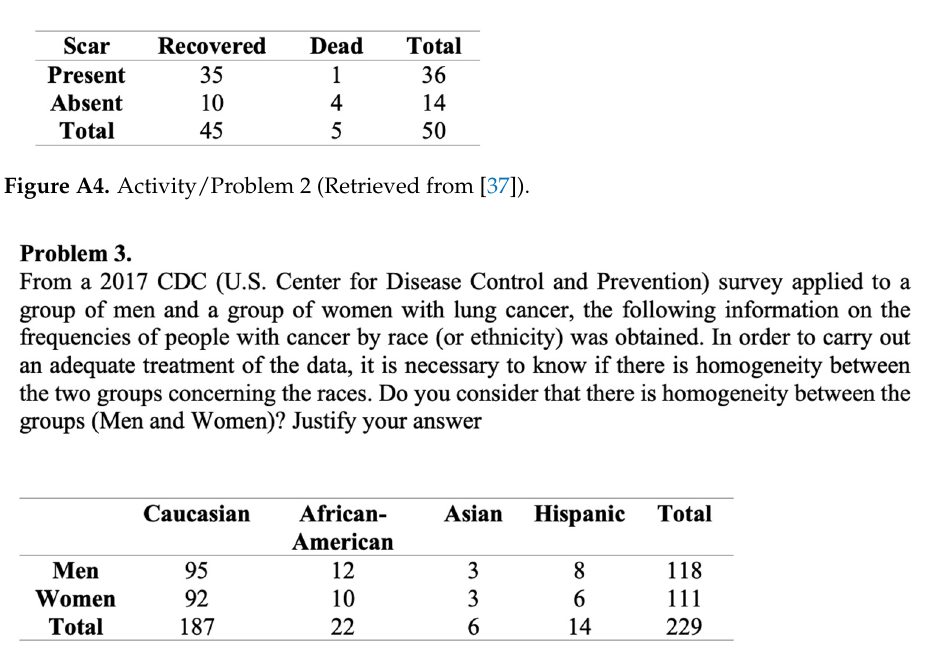
Figure A5. Activity/Problem 3 (Retrieved from [37]).